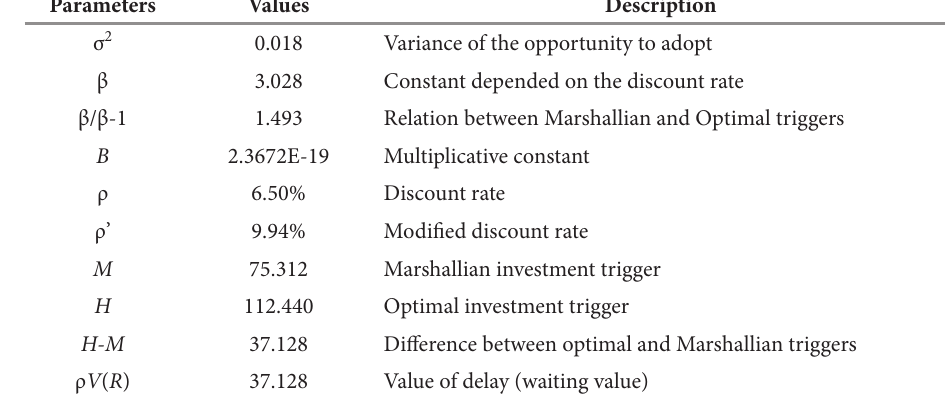
Table 4. Parameters for value of adopting opportunity and value of waiting Parameters